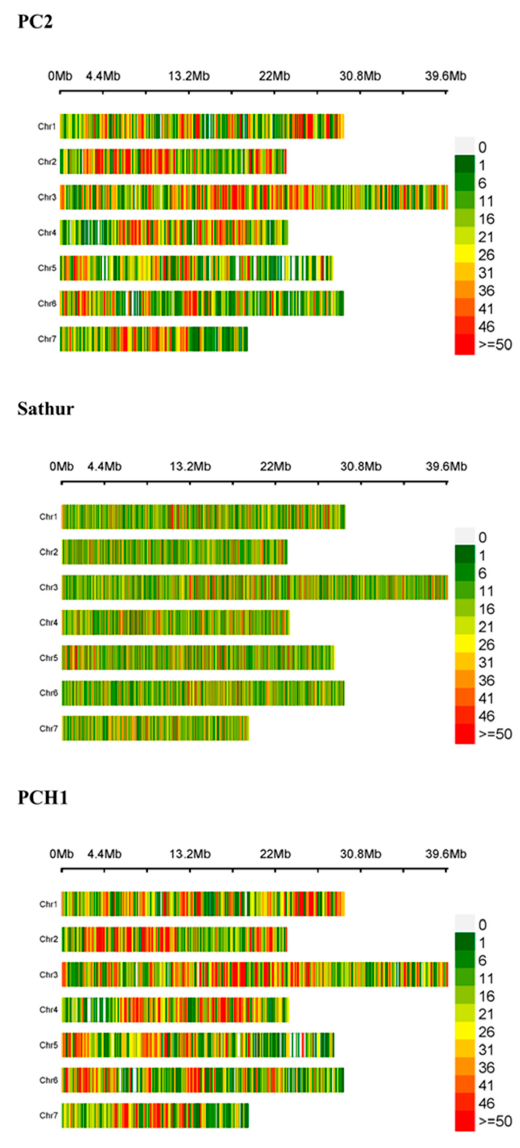
Figure 1. Graphical representation of SNPs identified in this study using the Cucumis sativus reference genome NSDC Assembly GCA_000004075.2. Table 4. Details of SNPs detected among the three investigated lines with respect to the reference genome. S. No.